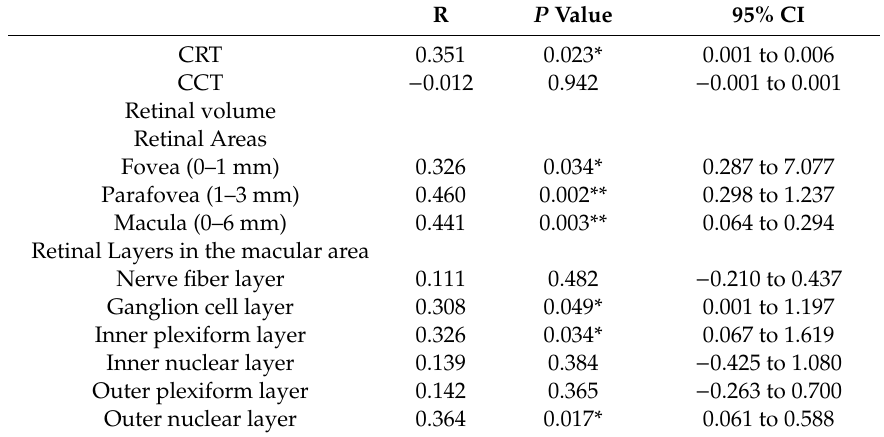
Adjusted for age. CRT, central retinal thickness; CCT, central choroidal thickness; MPOD, macular pigment optical density. ** P < 0.01, * P <